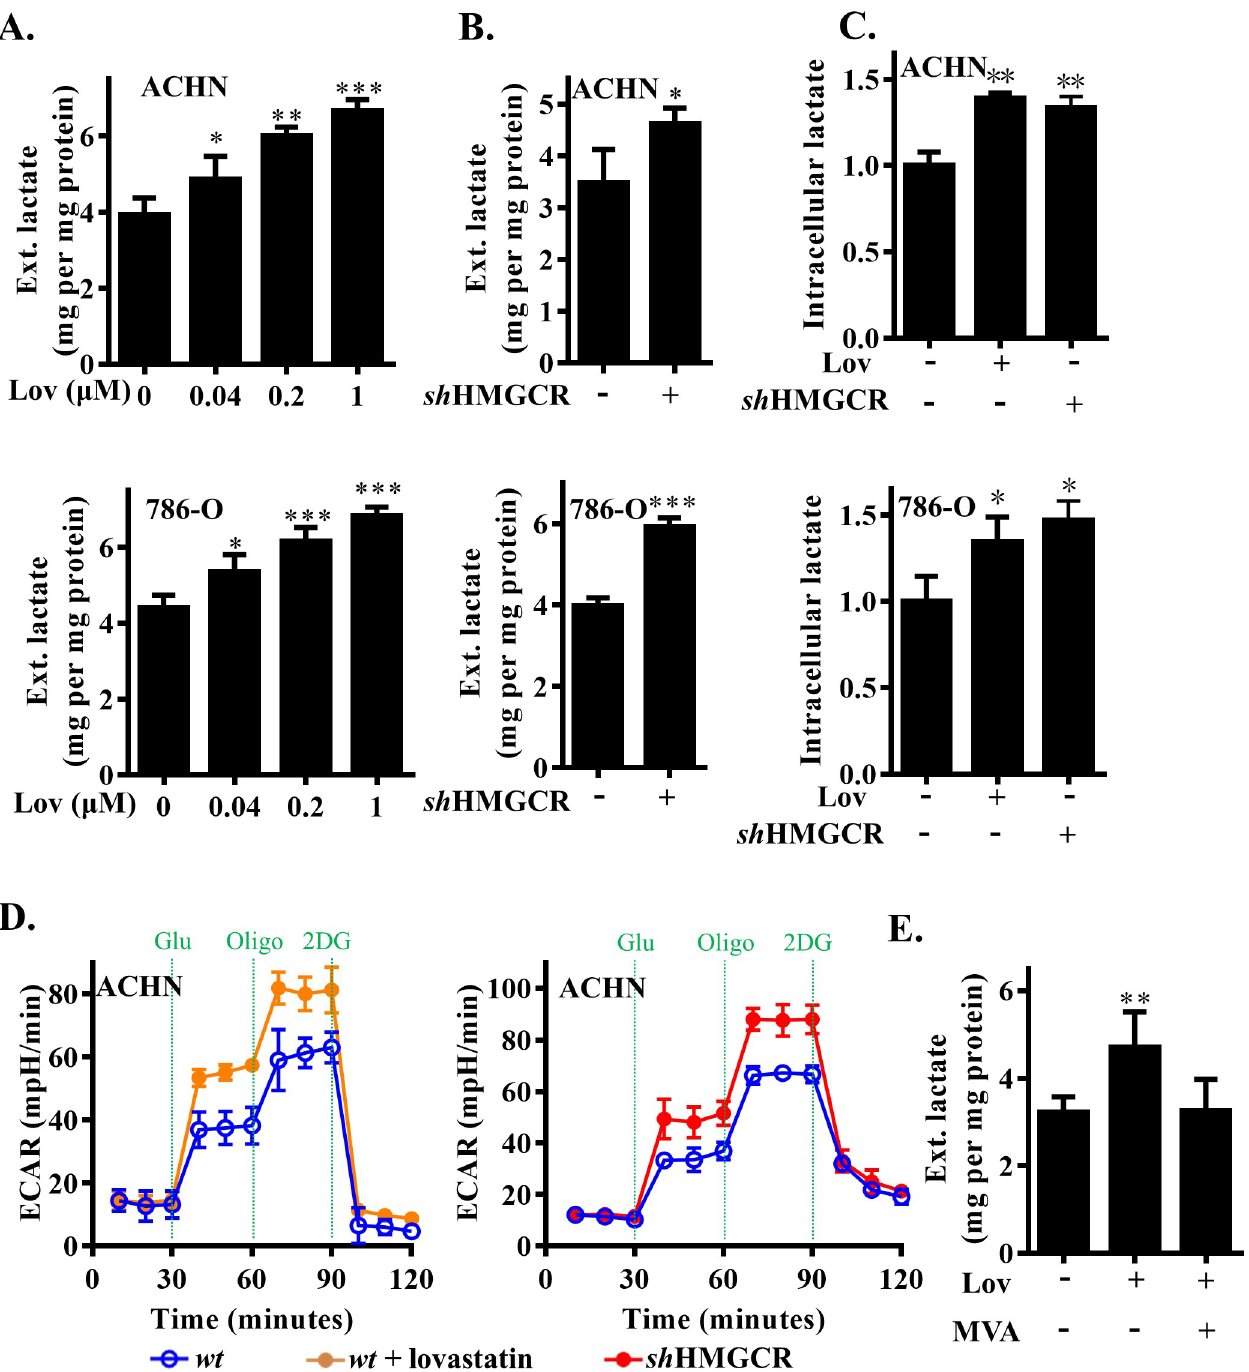
Fig 2. HMGCR inhibition enhanced RCC cells glycolytic. (A) Dose-dependent analysis of extracellular lactate level in ACHN and 786-O cells treated with lovastatin. (B) Extracellular lactate level in HMGCR knockdown and wild-type cells. (C) Intracellular lactate level in lovastatin, HMGCR knockdown, or wild- type RCC cells. (D) Kinetic ECAR response of sh HMGCR-ACHN cells or lovastatin-stimulated ACHN cells to 10 mM glucose, 2 μ M oligomycin, and 100 mM 2-DG. (E) Extracellular lactate level in ACHN cells with or without lovastatin and mevalonate treatment. The data are represented as the mean ± SD from 3 independent experiments, � (p � 0.05), �� ( p � 0.01), or ��� ( p � 0.001). 2DG, 2-deoxy-D-glucose; ECAR, extracellular acidification rate; Glu, glucose; HMGCR, 3-hydroxy-3-methylglutaryl coenzyme A reductase; Lov, lovastatin; MVA, mevalonate; Oligo, oligomycin; RCC, renal cell carcinoma; wt , wild type.